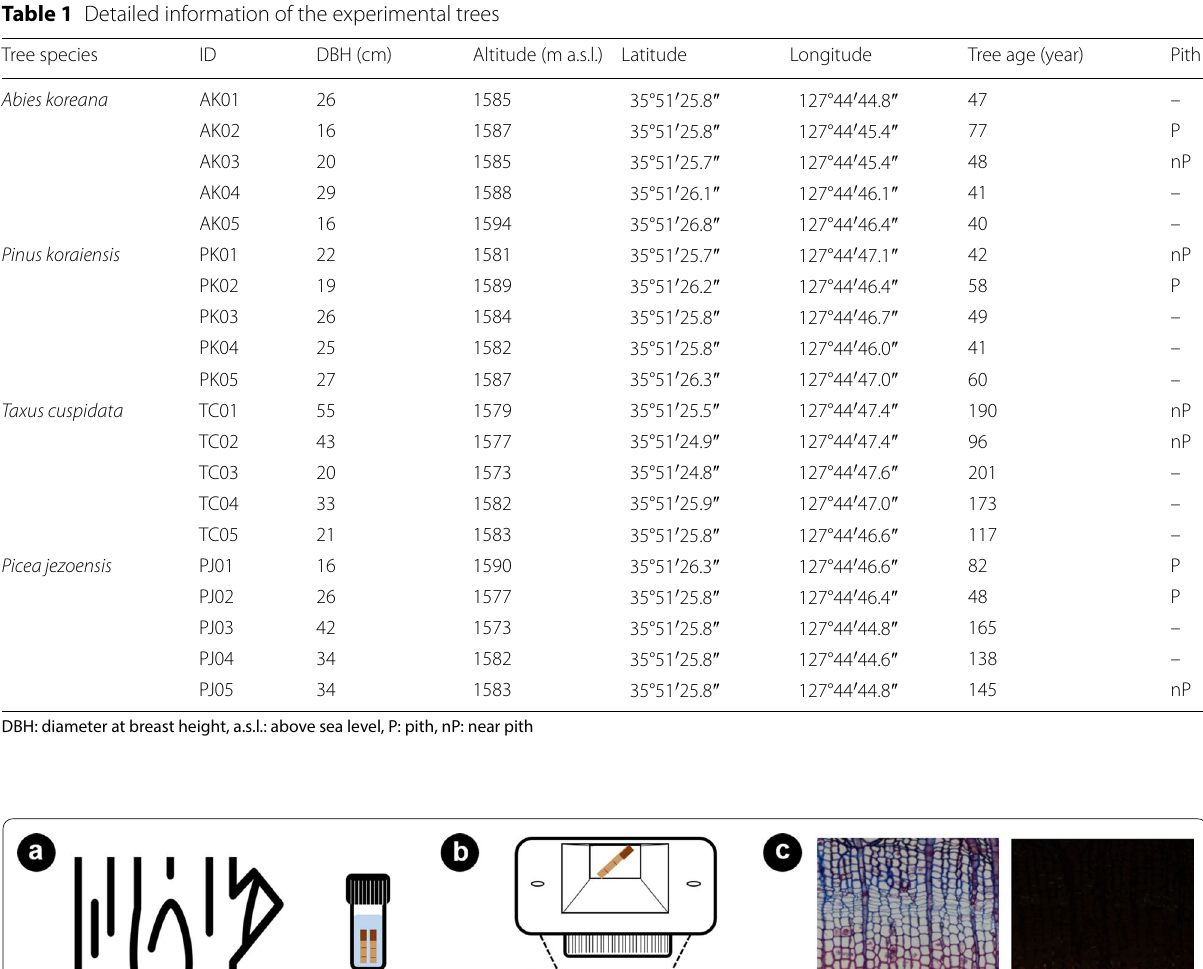
Table 1 Detailed information of the experimental trees Tree species